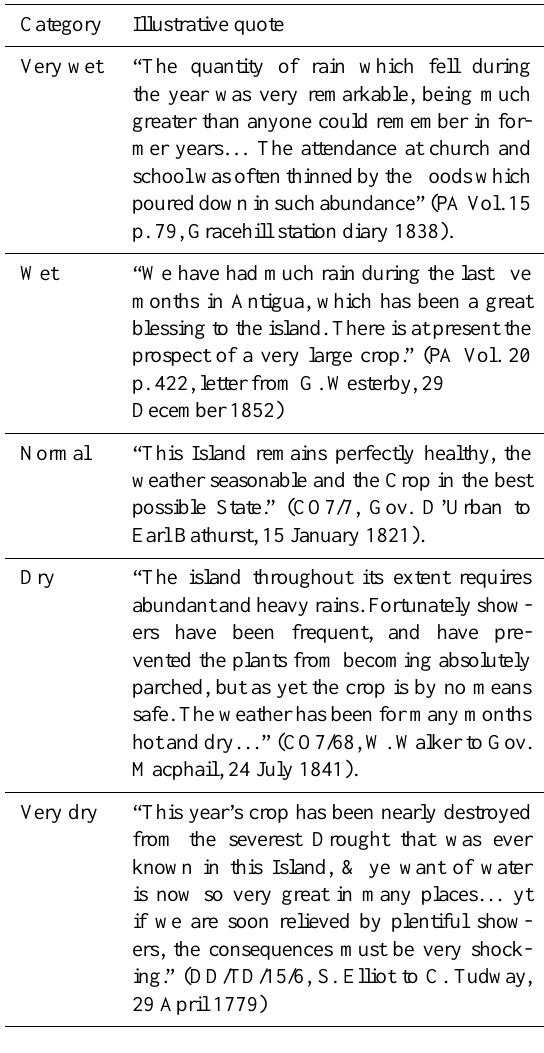
Table 2. Examples of statements characteristic of the five classifi- cations assigned to each